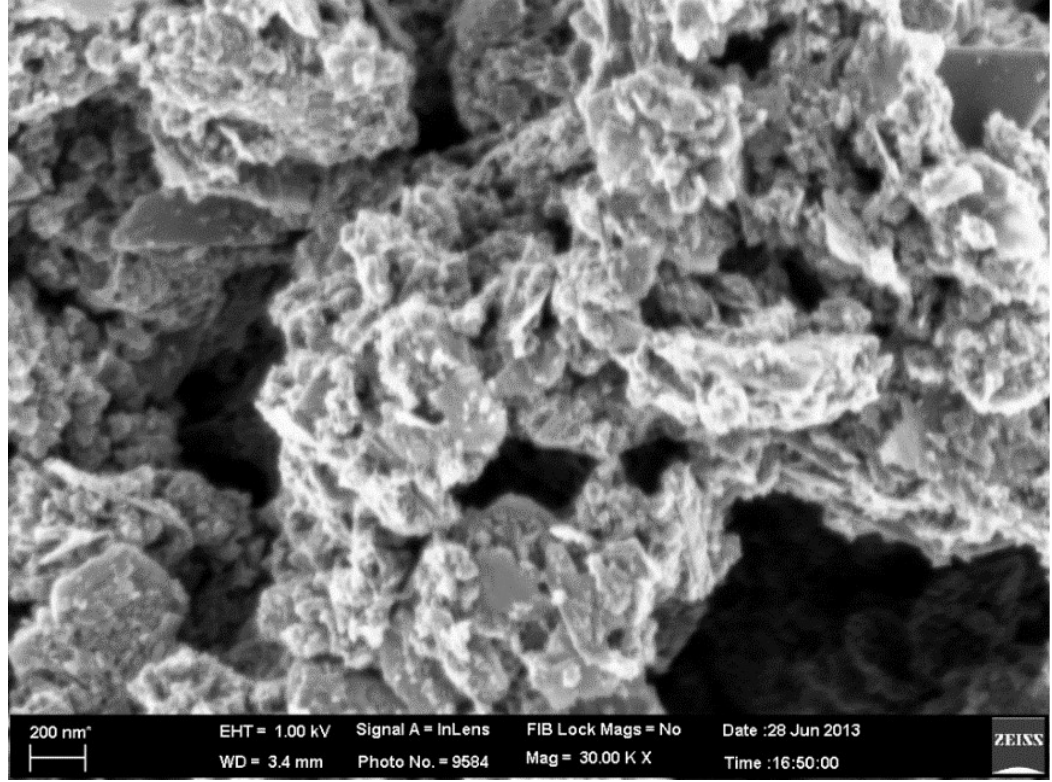
Figure 2. FESEM image of GNP with 30 KX magnification.